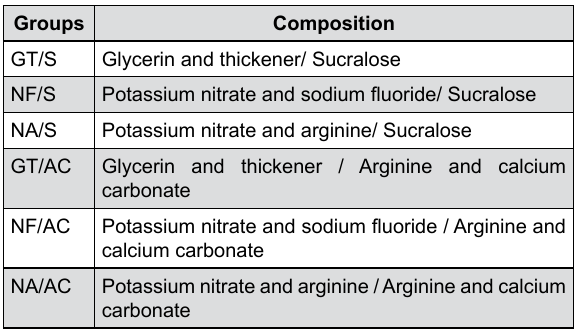
Figure 2- Groups and their active ingredients used in the